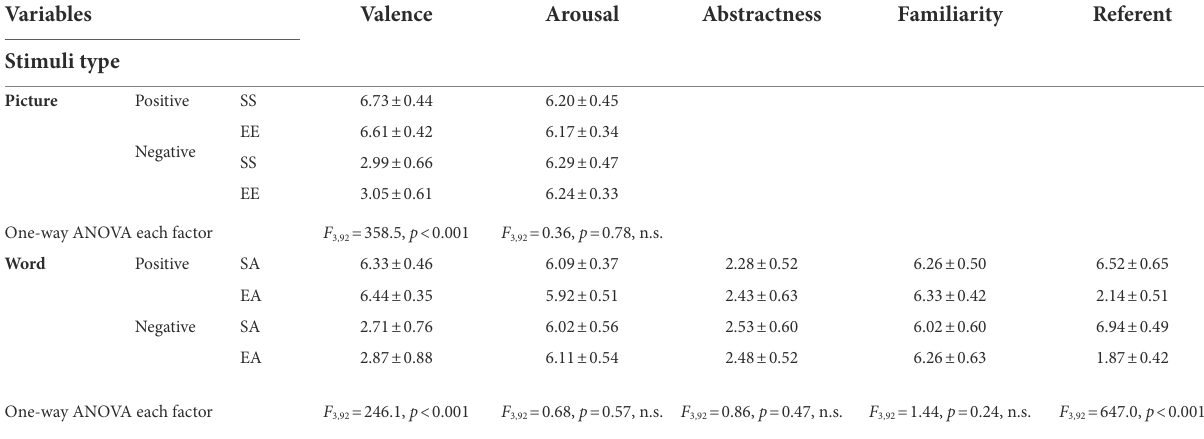
TABLE 1 Descriptive statistics for selected pictures and words